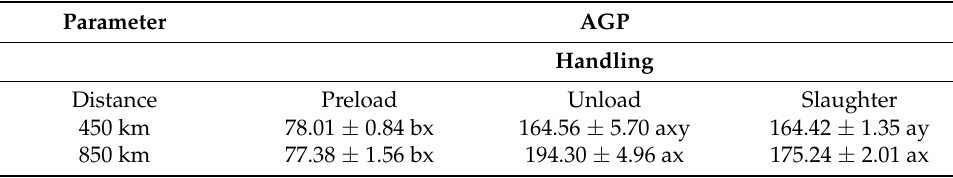
Table 7. Serum α -1 glycoprotein (AGP) as affected by the interaction between handling and distance in road transported